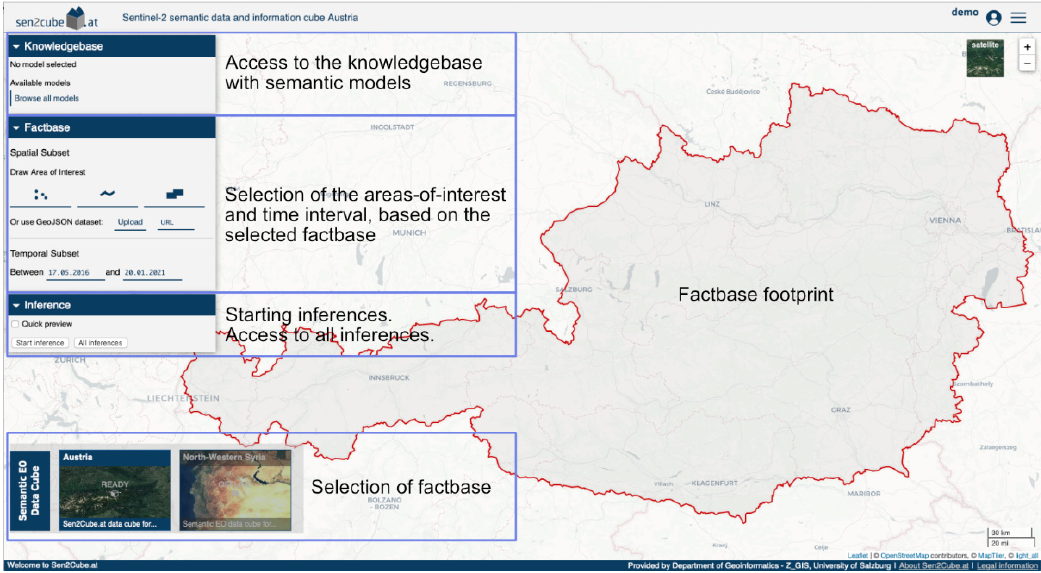
Figure 4. Sen2Cube.at’s GUI for semantic querying of big EO data. Here the Austrian factbase is selected, but other instances of factbases can be selected using the same GUI.